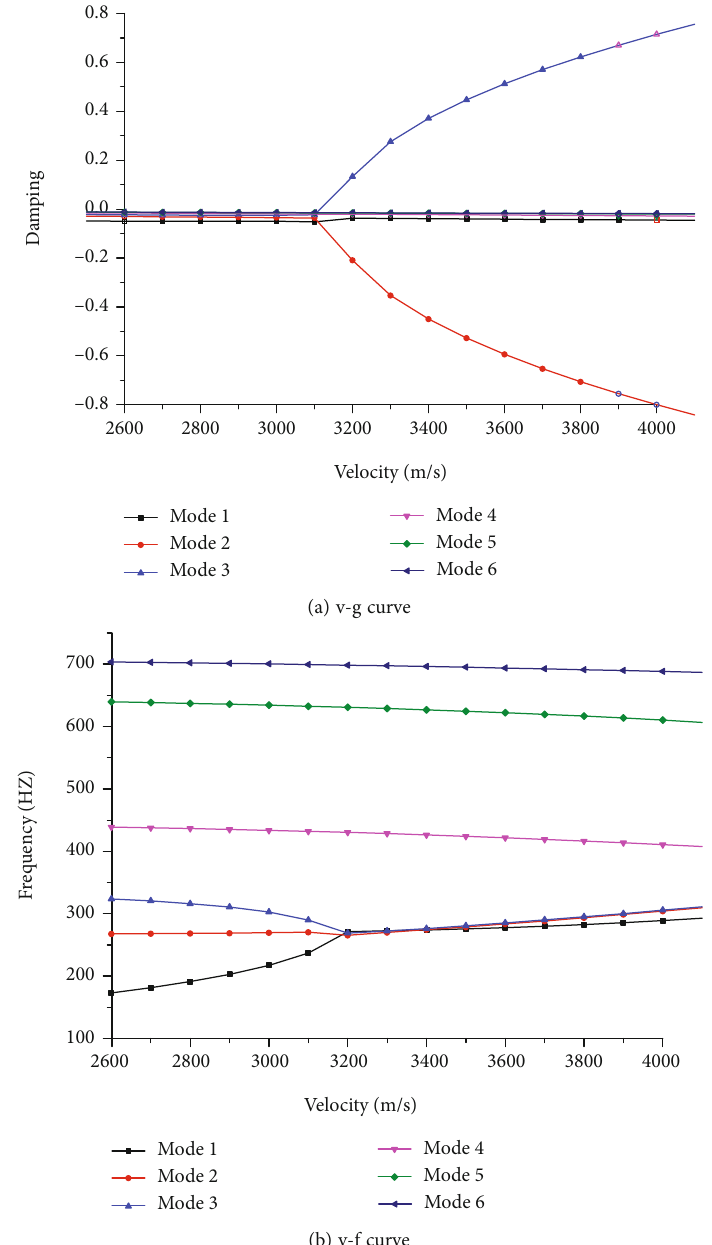
Figure 7: V-g and v-f curves for point